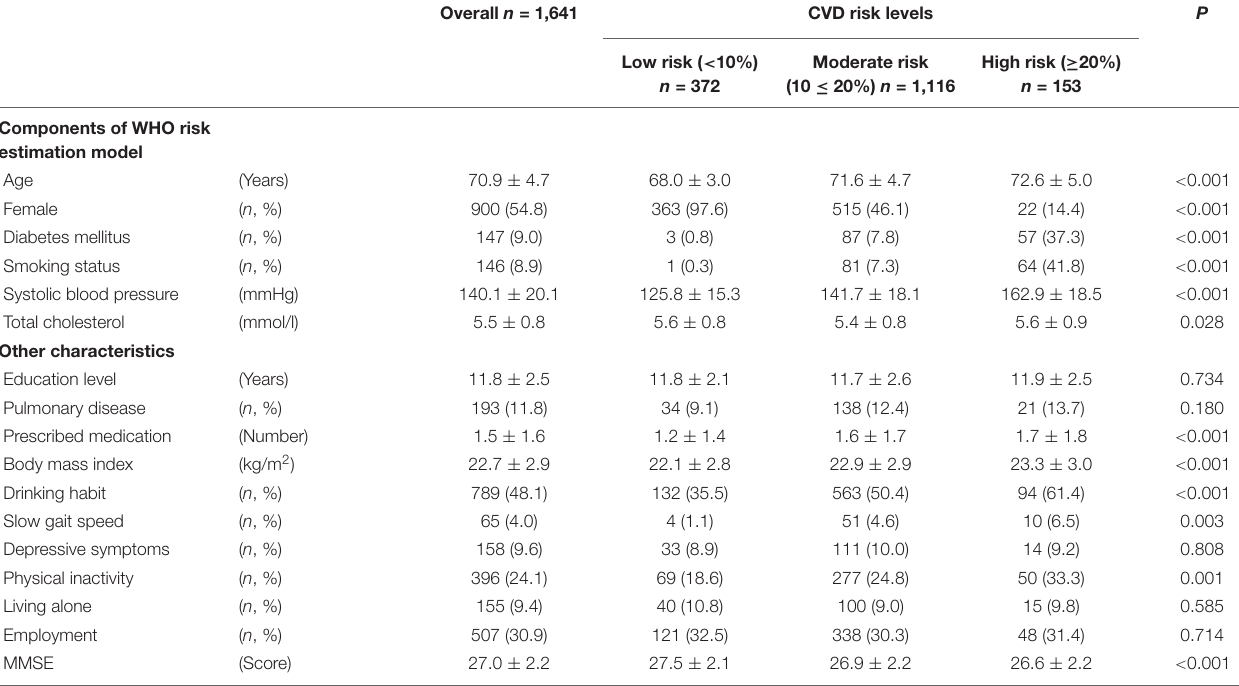
TABLE 2 | Baseline characteristics according to estimated CVD risk levels.